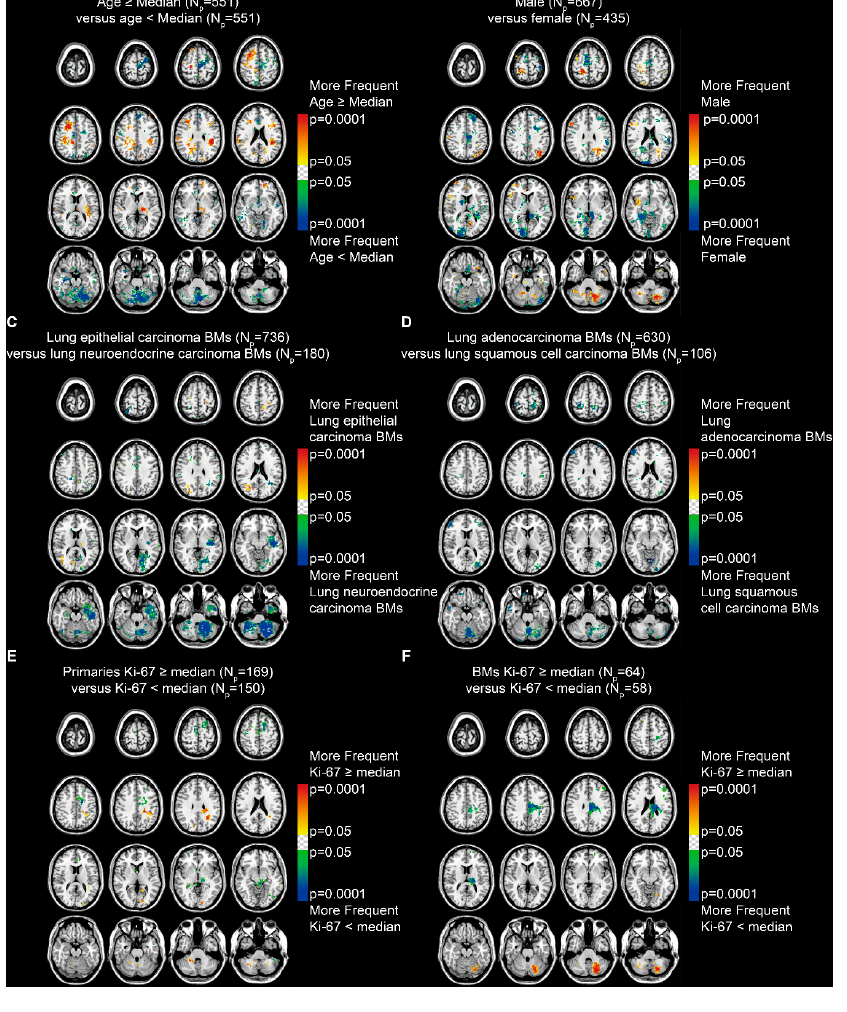
Figure 4. P -value heatmaps constructed by analysis of differential involvement (ADIFFI) displayed BMs’ cluster predom- inance. ( A ) Heatmaps comparing patients ≥ the median age (60.5 years) with those < the median age. ( B ) Heatmaps com- paring males with females. ( C ) Heatmaps comparing patients with lung epithelial carcinoma BMs with those with lung neuroendocrine carcinoma BMs. ( D ) Heatmaps comparing patients with lung adenocarcinoma BMs with those with lung squamous cell carcinoma BMs. ( E ) Heatmaps comparing patients with Ki-67 positivity in primaries ≥ the median (35%) with those < the median. ( F ) Heatmaps comparing patients with Ki-67 positivity in BMs ≥ the median (45%) with those < the median. BMs refer to brain metastases. N p refers to the number of patients.